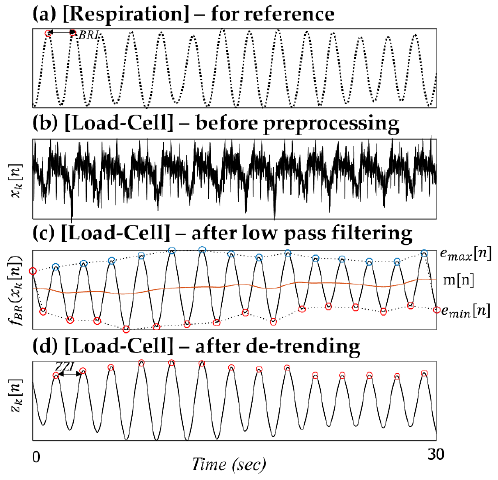
Figure 6. Pre-processing steps for BR analysis.